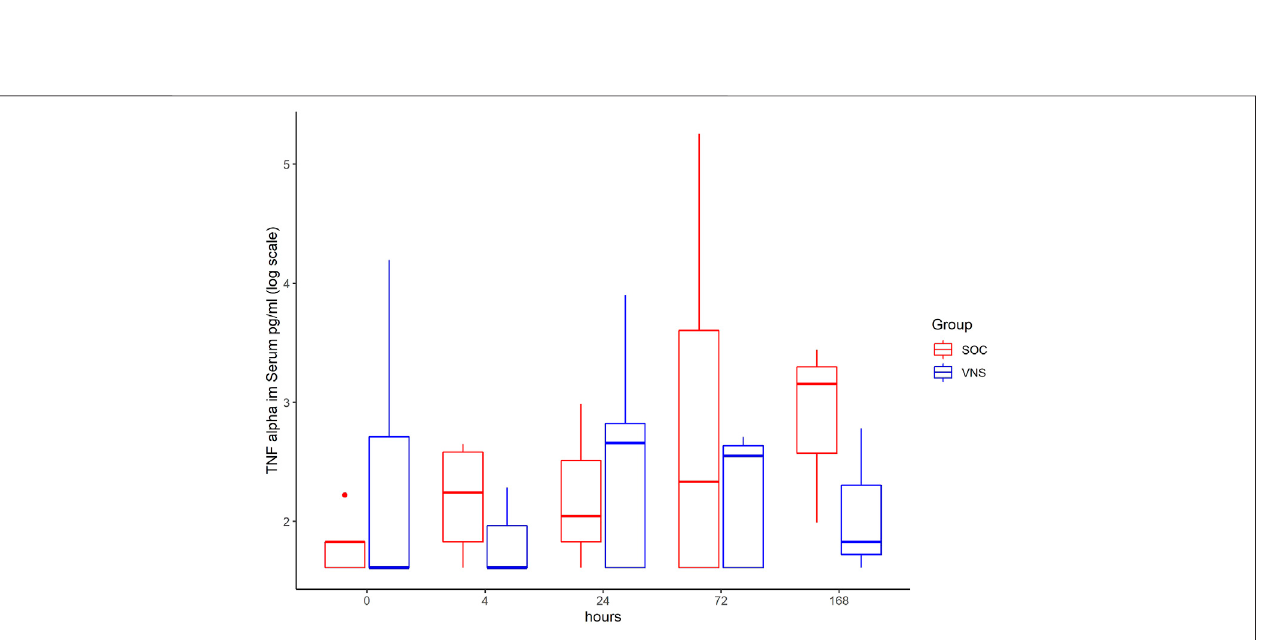
Frontiers in Physiology |